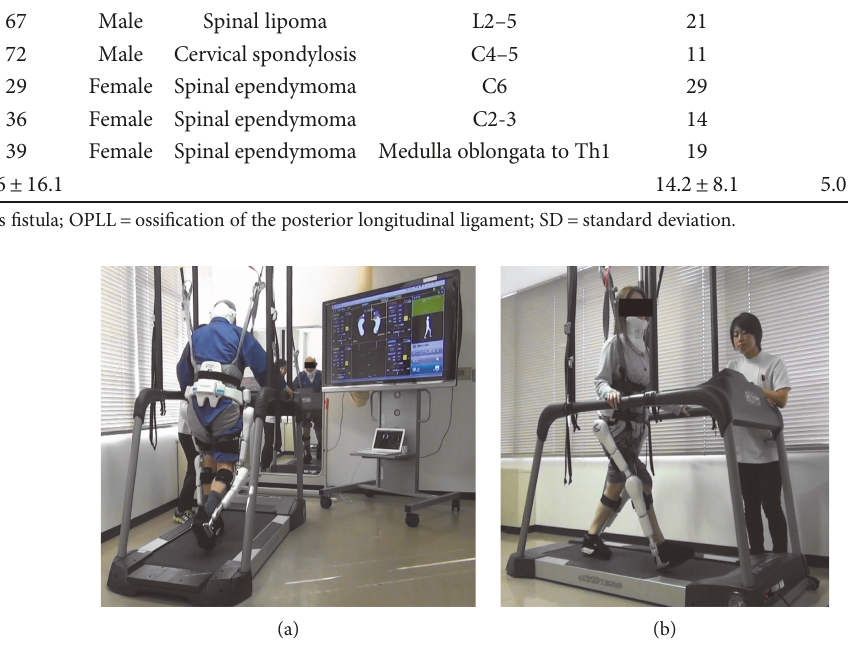
Figure 2: (a, b) Hybrid Assistive Limb (HAL) treatment. Gait training on a treadmill in front of a large